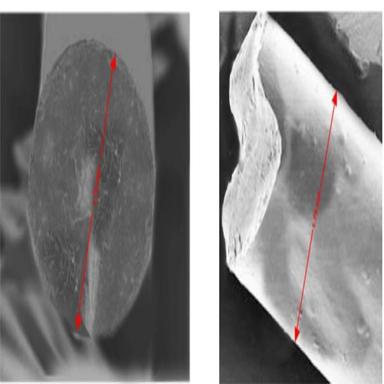
Magnified view and diameter measurement of PLA-G-CF filament.